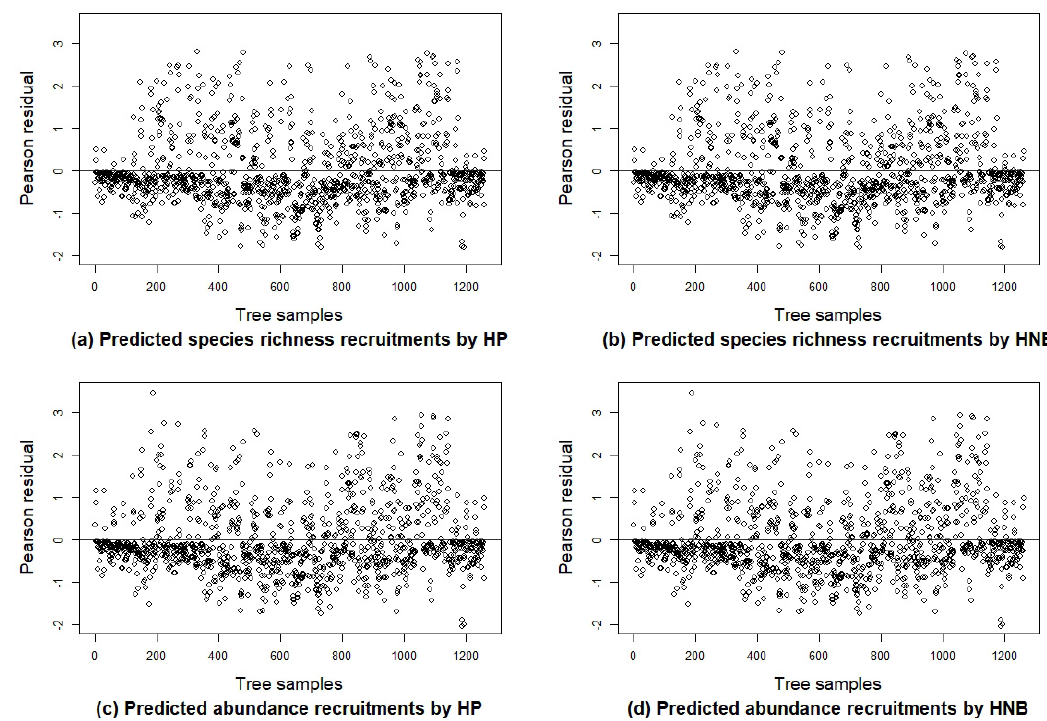
Figure 4. Pearson residual plots of epiphytic bryophyte recruitments for Hurdle-Poisson (HP) and Hurdle-negative binomial (HNB) models for species richness ( a , b ) and abundance ( c , d ).